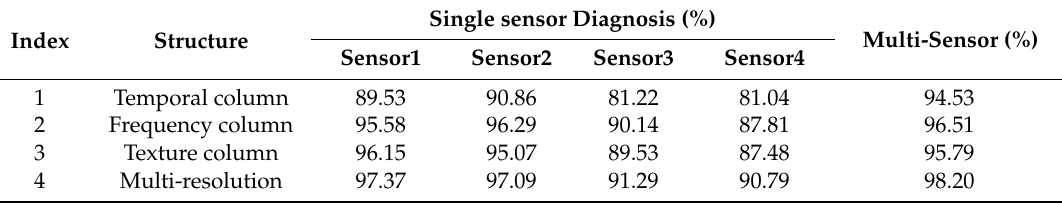
Table 4. Diagnostic accuracies and the intermediate outputs for classifying the defect types